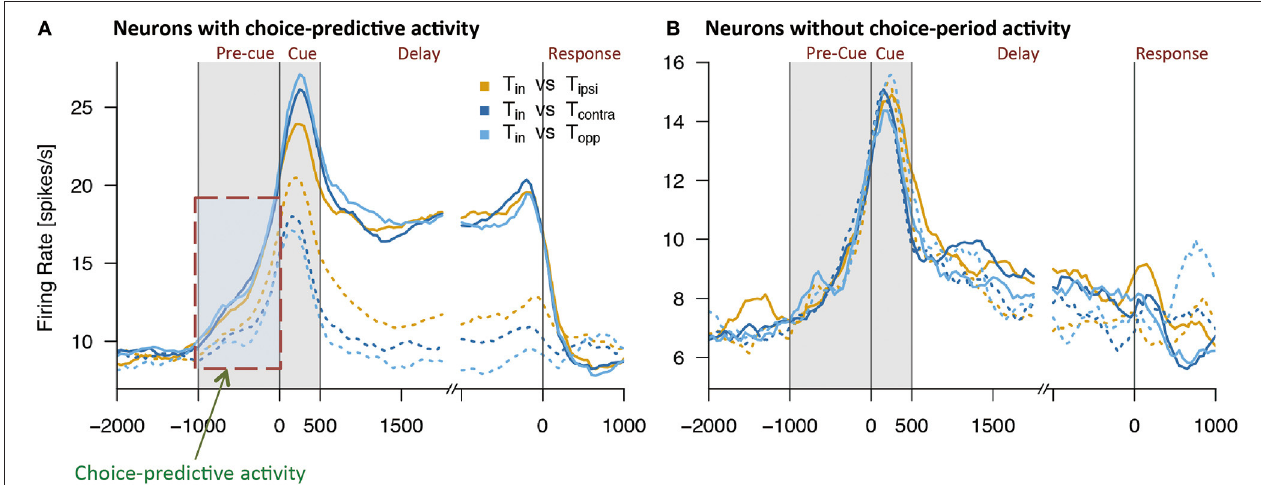
FIGURE 4 | Examples of activities observed in two groups of prefrontal neurons while monkeys performed free-choice tasks. (A) Temporal patterns of activities observed in prefrontal neurons with choice-predictive activity. This neuron exhibited significant choice-predictive activity and delay-period activity when the monkey selected saccade directions toward the neuron’s preferred direction (solid lines), regardless of wherever the remaining cue was presented (dotted lines). (B) Temporal patterns of activities observed in prefrontal neurons without choice-predictive activity. This neuron exhibited the same temporal patterns of activity regardless of whether the monkey selected saccade directions toward the neuron’s preferred direction (solid lines) or non-preferred directions (dotted lines). T in indicates the monkey’s selection of the neuron’s preferred direction (solid lines) and T ipsi , T contra , and T opp indicate the monkey’s selection of the neuron’s non-preferred directions (dotted lines). Figures are reproduced from Mochizuki and Funahashi (2016) with permission from the copyright